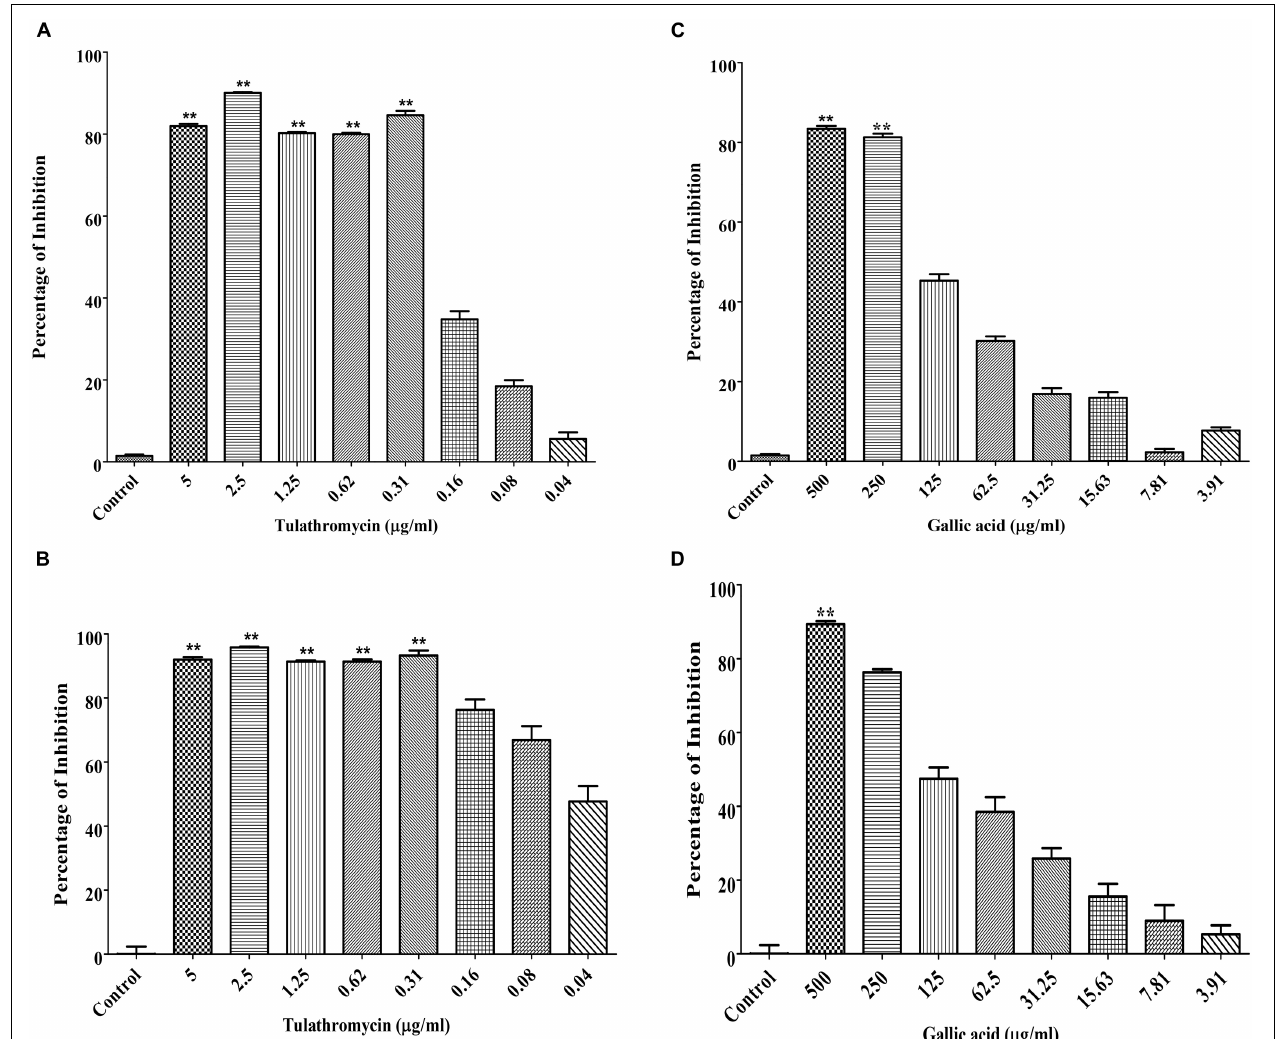
FIGURE 1 | Determination of the MICs of tulathromycin against M. haemolytica (A) and P. multocida (B) and the MICs of gallic acid against M. haemolytica (C) and P. multocida (D) . The concentration of tulathromycin was ranging from 0.04 to 5 µ g/mL and the concentration of gallic acid was ranging from 3.9 to 500 µ g/mL. Bacterial cell culture medium, Brain-Heart Infusion broth (BHIB), was used as a negative control. One way ANOVA t -test was used for statistical significance. ∗ P -value < 0.05, ∗∗ P -value < 0.01, and ∗∗∗ P -value < 0.001 are shown. Correlation coefficient ( r ) was calculated using Pearson’s correlation method.